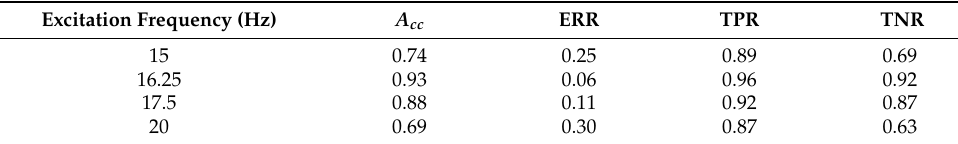
Figure 14. Results for an excitation frequency of 17.5 Hz with optimum threshold. Table 4. Methodology’s performance